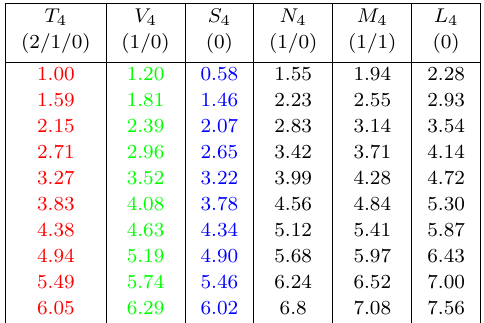
Table 2 . Numerical results for the spectrum of masses M n of fluctuations computed in ref. [163] (corresponding to φ = 0 ). In respect to the original source, besides showing the mass, rather than I the mass square, we normalise the spectrum to the lightest spin- 2 particle — labelled T of the states are explained in ref. [163], and we put in bracket the spin of the states, highlighting the degeneracies. All states are SO(5) singlets. We highlight in red, green and blue, respectively, the SO(5) singlet states that appear also in our own results (see table 3 for comparison). The three heavier towers are not part of the spectrum we compute.